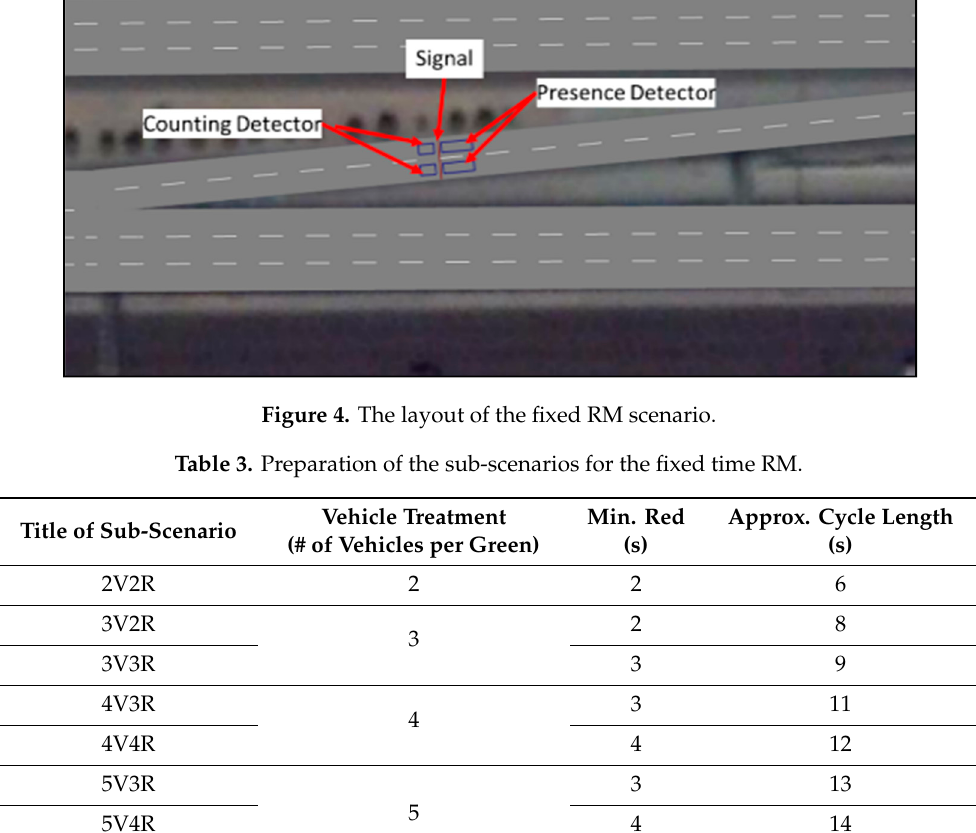
Figure 4: the first detector (presence detector) senses vehicle access to the signal and the second detector (counting detector) counts the number of vehicles that pass the signal.